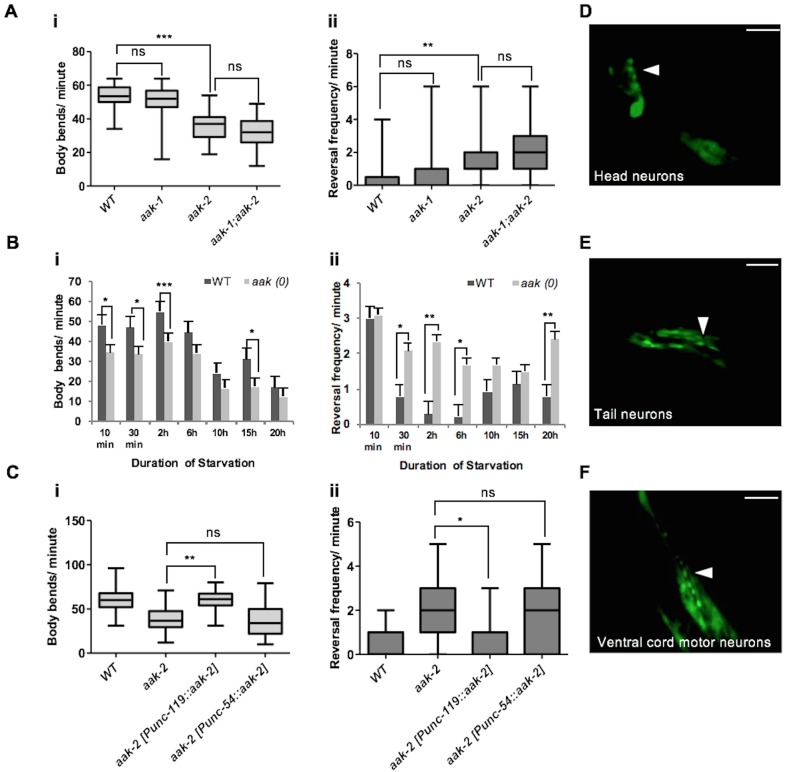
Neuronal AMPK regulates distal exploratory behaviour in starved animals.(A) Starved aak-2 mutants display defective transition from local to distal exploration indicated by (i) decreased forward locomotion and (ii) increased reversal rate during acute bouts of starvation. These phenotypes are not dependent on aak-1 (n>40), (one-way ANOVA **p<0.001, ***p<0.0001). (B) AMPK mutants display persistent decreased forward locomotion rate (i) and increased reversal frequency (ii) during periods of acute starvation (n>10), Error bars represent ± SEM (Student's t-test, *p<0.05, **p<0.001, ***p<0.0001). (C) aak-2 reconstitution within the nervous system using the pan-neural [Punc-119::aak-2] transgene rescues the defective distal exploratory behaviour in starved aak-2 mutants while its reconstitution within the body wall muscle using [Punc-54::aak-2] transgene does not improve the distal exploratory behaviour of aak-2 mutants (n>15), (one-way ANOVA *p<0.05, **p<0.001). (D,E,F) aak-2 is highly expressed throughout the nervous system. Scale bars are 40 μm. In the box and whisker plots (A,C) the central line is the median, the edges of the box are the 25th and 75th percentiles, and the whiskers extend to the most extreme data points.DOI:
http://dx.doi.org/10.7554/eLife.16349.00310.7554/eLife.16349.004Figure 1—source data 1.Locomotory behaviour in AMPK mutant animals.DOI:
http://dx.doi.org/10.7554/eLife.16349.00410.7554/eLife.16349.005Figure 1—source data 2.Food and stimuli-related behaviours in AMPK mutants.DOI:
http://dx.doi.org/10.7554/eLife.16349.00510.7554/eLife.16349.006Figure 1—source data 3.Locomotory behaviour upon depletion of aak-2 with 1535 RNAi.